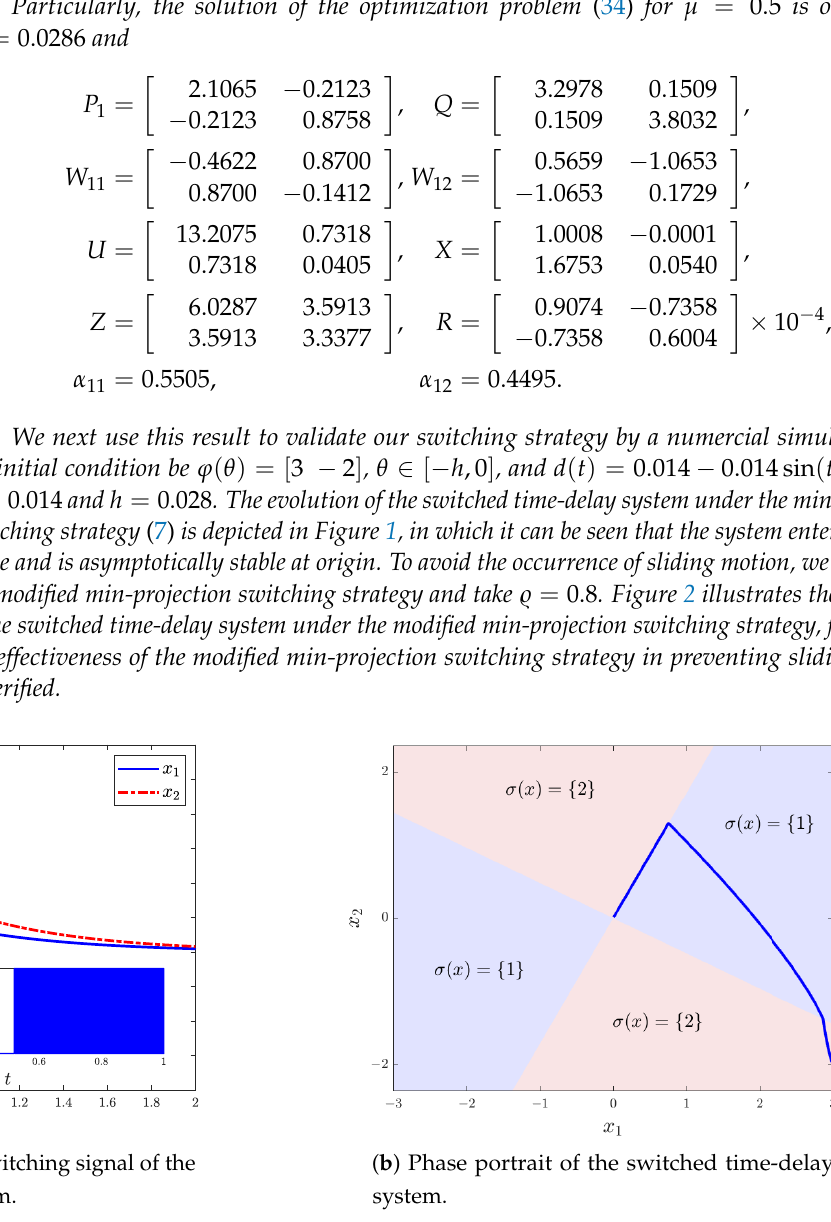
Figure 1. Example 1: evolution of the switched system under the min-projection switching strategy